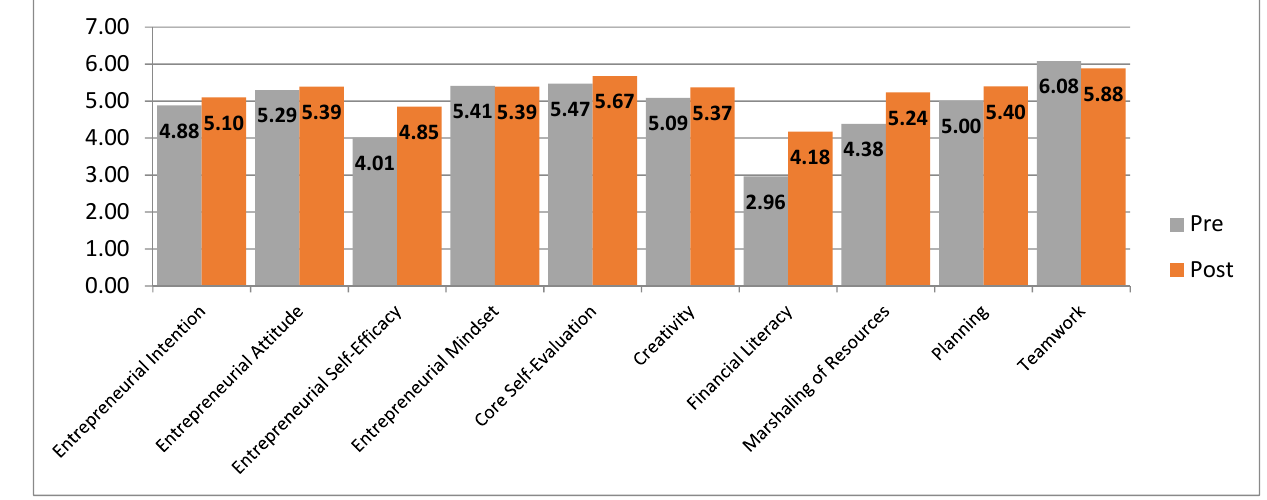
Figure 7. The average values of the entrepreneurial characteristics, pre- and post-course, of the students who had had no experience in practical entrepreneurship programs.